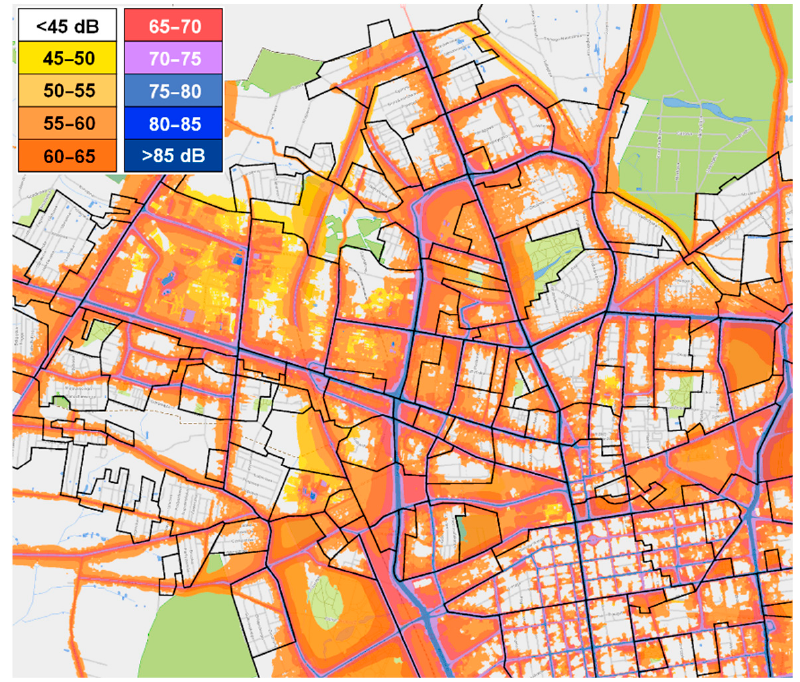
Figure 4. The background noise level.